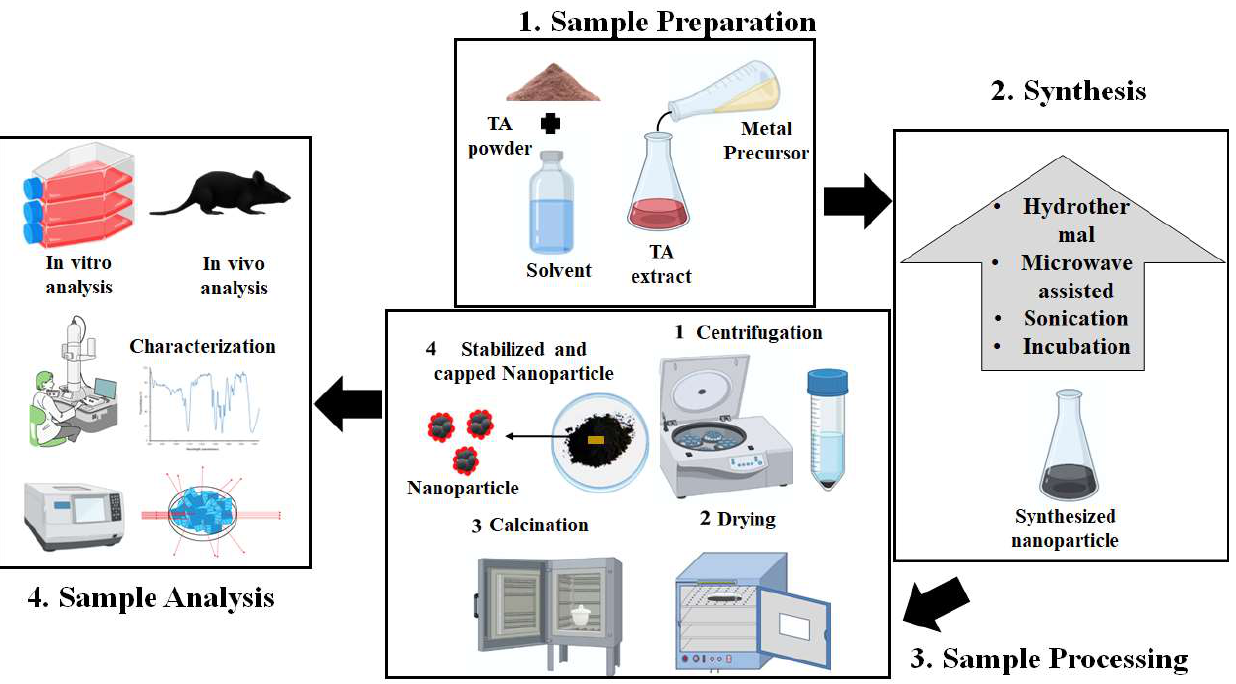
Figure 7. Schematic representation of the various steps involved in the green synthesis of metallic nanoparticles using TA extract. nanoparticles using TA